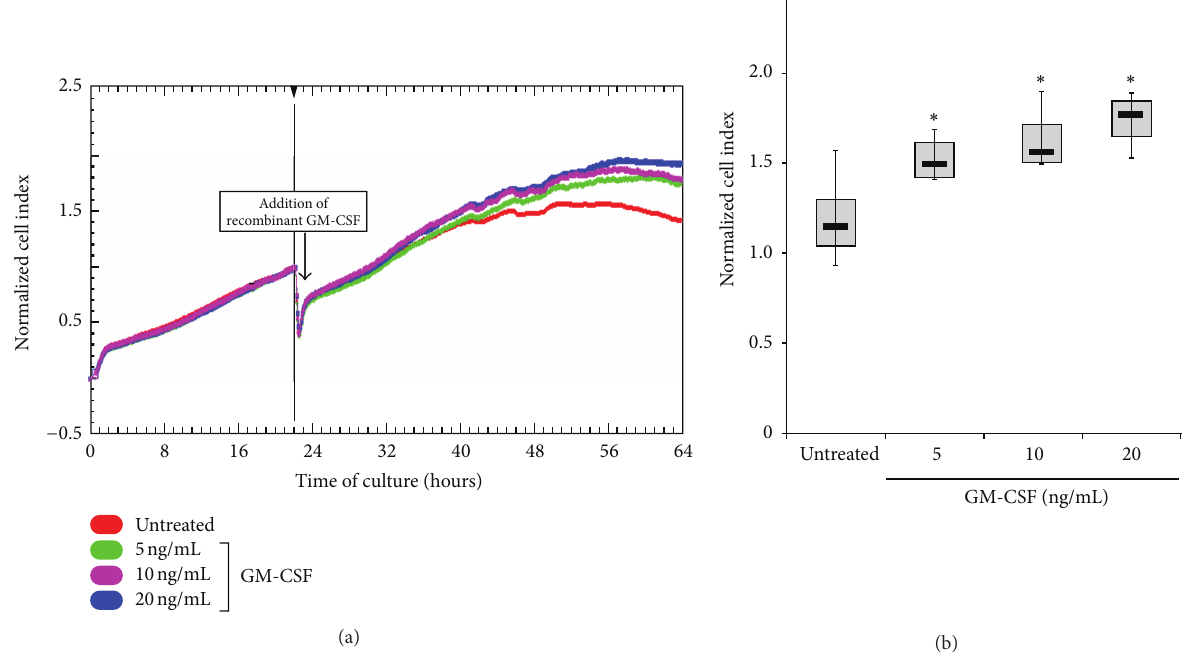
Figure 2: GM-CSF treatment induces in vitro VEC proliferation. Dynamic monitoring of endothelial cells proliferation using the xCELLigence system. VEC were seeded at a density of 5.000 cells/well per well in quadruplicate in fibronectin-coated 16 wells E-plates and left adhere for 22 h when recombinant GM-CSF was added to the cultures at the indicated concentrations. In (a), cell proliferation was recorded and expressed as cell index (CI) after normalization to the CI recorded at the time of GM-CSF addition (arrow). A representative panel of GM-CSF-treated and untreated cell proliferation expressed as normalized CI is shown. In (b), the dose-dependent effect of GM-CSF in inducing VEC proliferation is shown as normalized CI of result from 4 independent VEC cultures. Horizontal bars are median, upper, and lower edges of box are 75th and 25th percentiles; lines extending from box are 10th and 90th percentiles. ∗ 𝑃 < 0.05 compared to untreated